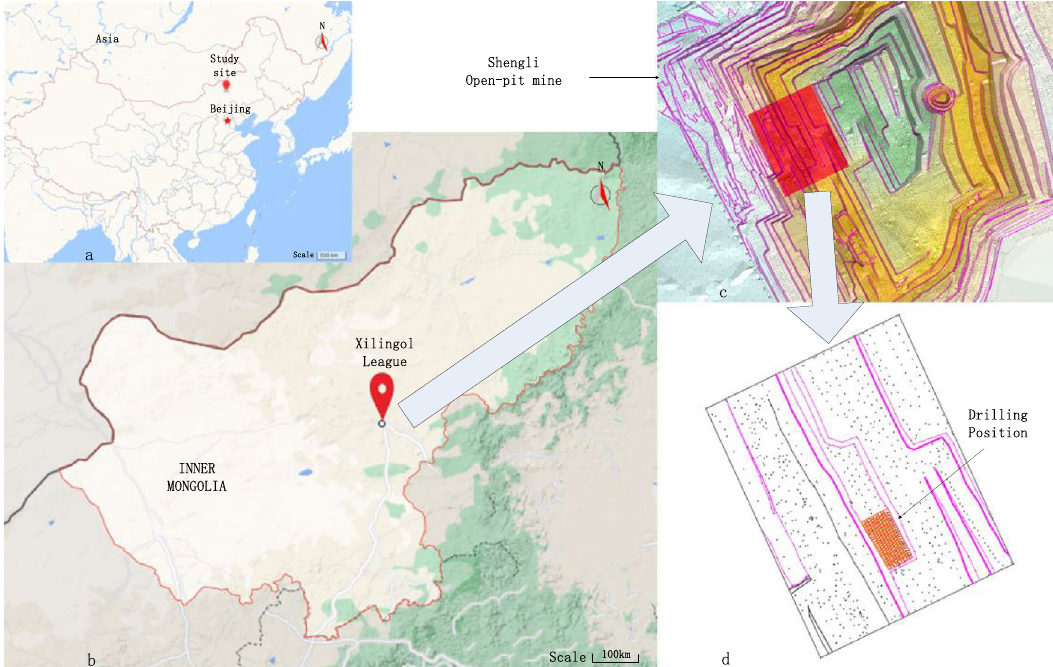
Figure 3. Shengli open-pit coal mine, Xilinhot, Inner Mongolia Autonomous Region, China. This figure is synthesized by Visio 2013 (https:// www. micro soft. com/ zh- cn/ micro soft- 365/ previ ous- versi ons/ micro soft- visio- 2013), and ( a ) and ( b ) in this figure are downloaded by Google maps (https:// www. google. com/ maps).